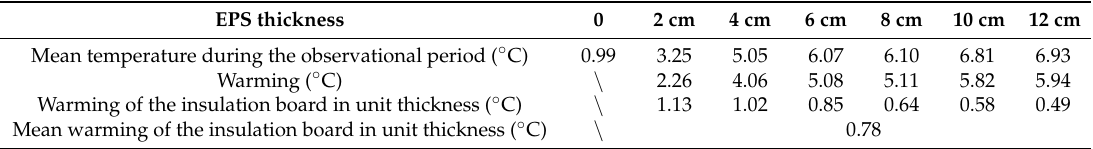
Table 4. Warming effects of the EPS in unit thickness (at a buried depth of 30